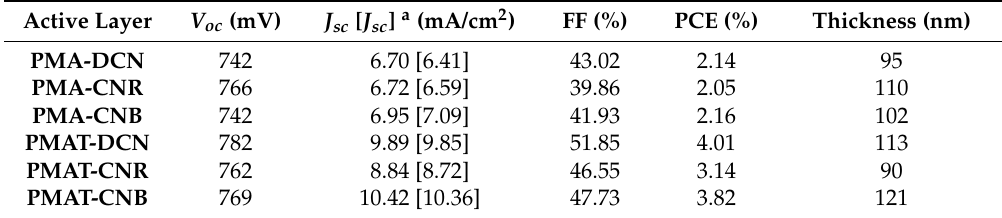
Figure 4. J-V characteristics of copolymer/PC 71 BM bulk heterojunction solar cells under illumination of AM 1.5 G, 100 mW cm − 2 . Table 3. Photovoltaic performances of devices under the illumination of AM 1.5 G, 100 mW cm − 2